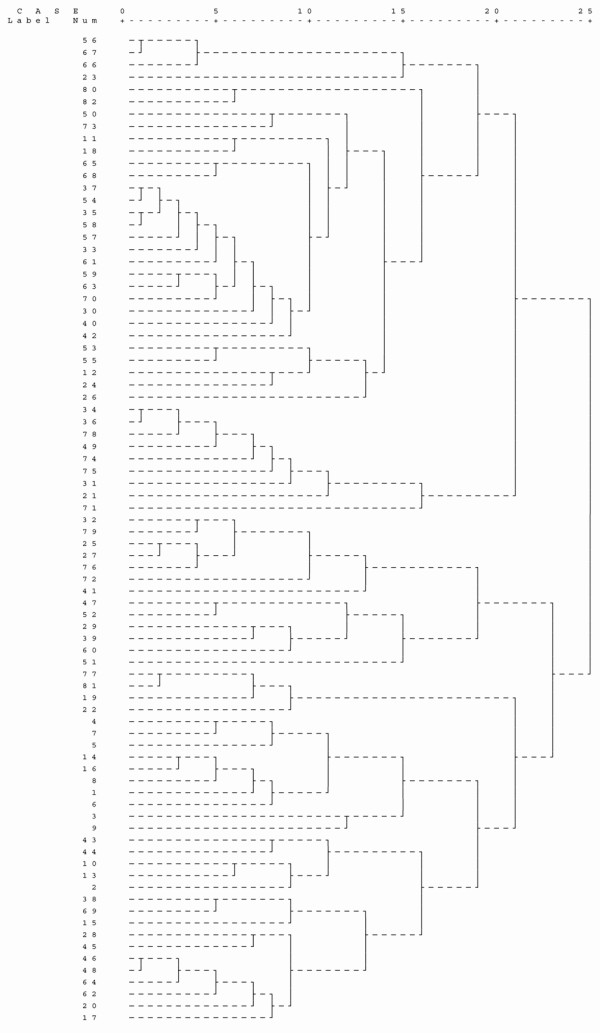
Unsupervised clustering analysis using synovial histopathological parameters identified two main clusters within the spondyloarthropathy cohort (n = 82). The dendrogram represents the 82 spondylarthropathy cases on the y-axis, classified according to their similarity for the histological parameters. The degree of similarity is represented as rescaled distance on the x-axis: when two samples are closely similar the distance will be small, whereas a rescaled distance of 25 represents a high degree of histological difference.